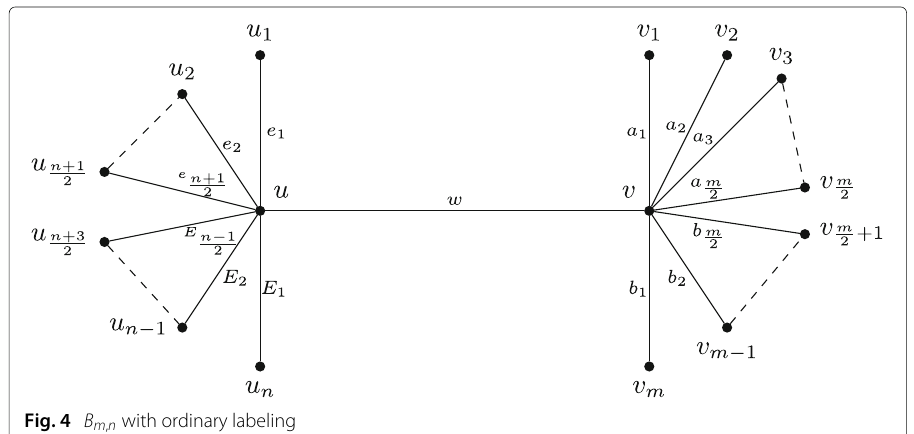
Fig. 4 B m , n with ordinary